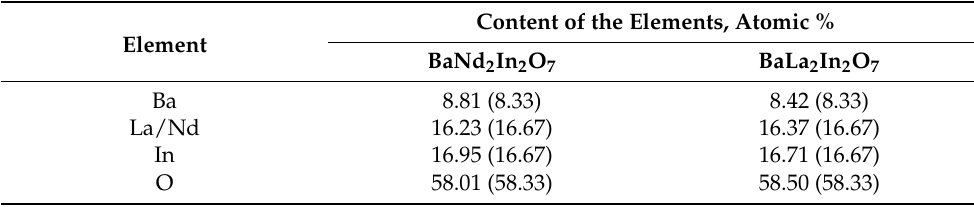
Table 2. The average metal ratios determined by EDS analysis for the BaNd 2 In 2 O 7 and BaLa 2 In 2 O 7 compounds (theoretical values are given in the brackets).